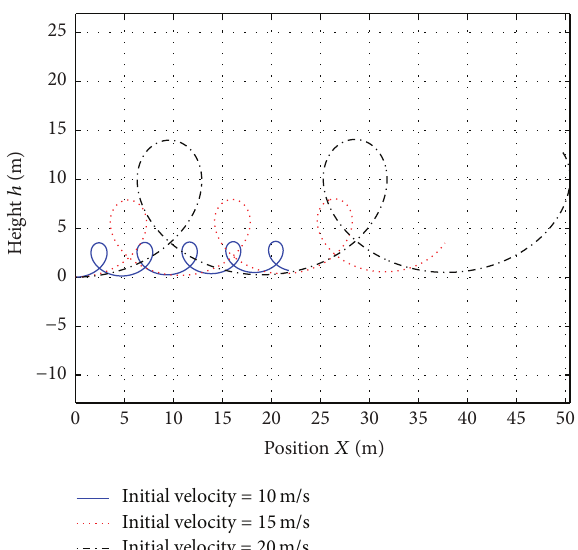
Figure 7: Varying the initial velocity at 3.5𝑔 normalised thrust for the same period of